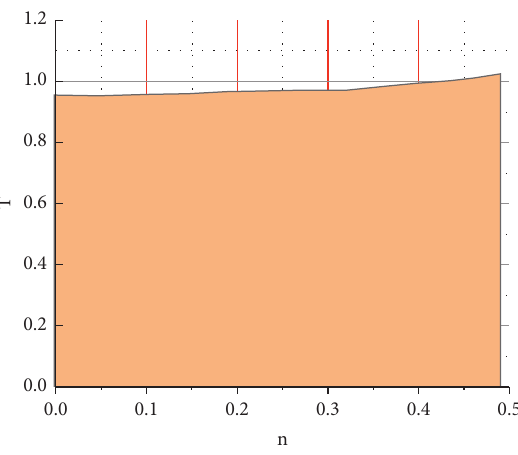
Figure 8: Long-term advertising recovery rate.